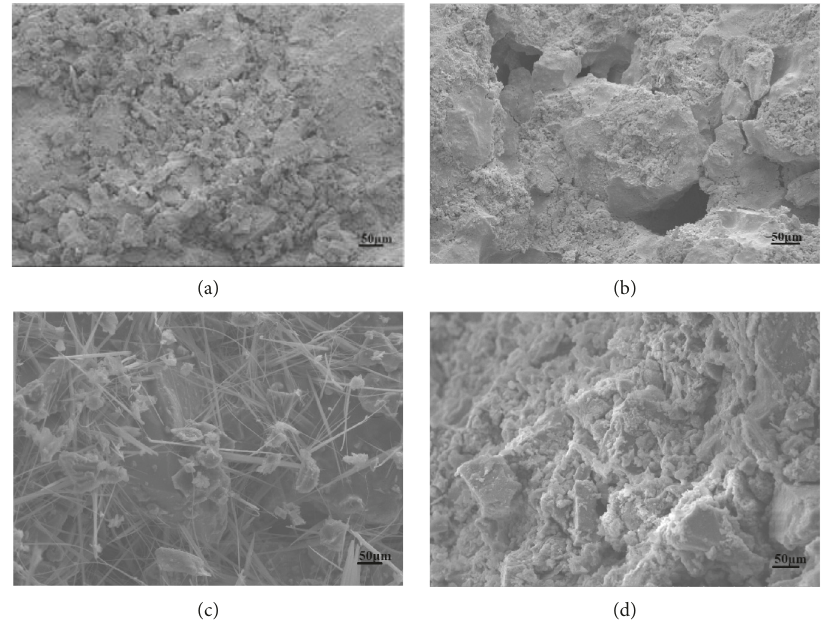
Figure 14: SEM image of the lunar soil simulant. (a) Sodium silicate content is 0%. (b) Sodium silicate content is 3%. (c) Sodium silicate content is 5%. (d) Sodium silicate content is 7%.